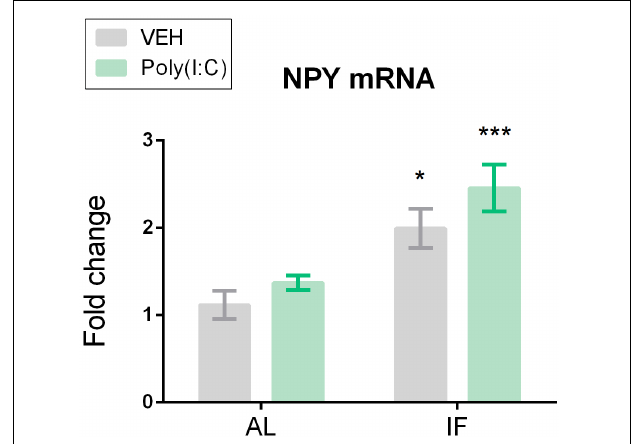
FIGURE 6 | Neuropeptide Y (NPY) mRNA expression is significantly upregulated in the hypothalamus of intermittently fasted mice. Mice were kept on an ad libitum feeding regimen (AL) or deprived of food on every other day (IF) for 9 days. On day 10, mice were injected i.p. with vehicle (VEH) or Poly(I:C) (12 mg/kg) and 4 h later brains were extracted to evaluate NPY mRNA expression in the hypothalamus. Values represent means ± SEM, n = 6–8. Results of two-way ANOVA: F (1, 25) = 0.2708, p = 0.6074 for interaction of feeding regimen/Poly(I:C) in NPY mRNA; F (1, 25) = 24.45, p ≤ 0.0001 for main effect of feeding regimen on NPY mRNA; F (1, 25) = 3.262, p = 0.083 for main effect of Poly(I:C) on NPY